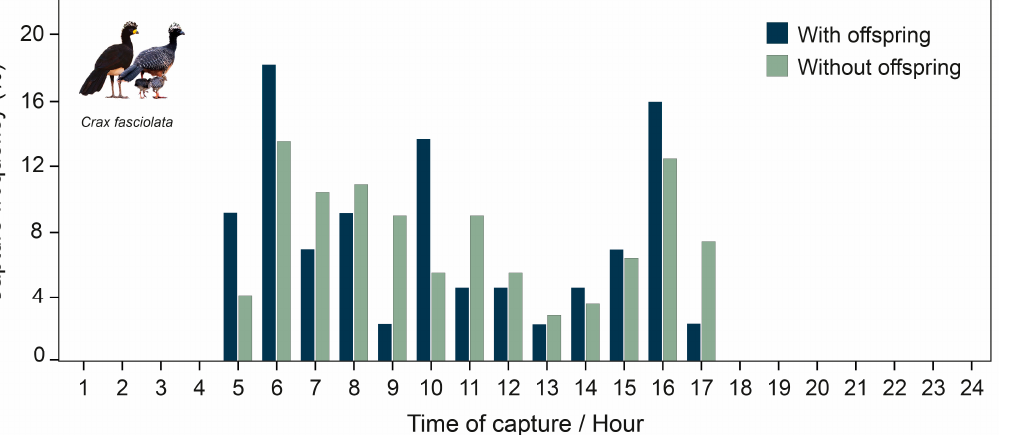
Figure 5. Frequency (%) of independent captures of Bare-faced Curassow ( Crax fasciolata ) (based on a 30 min independence interval) with and without offspring obtained in the Northern Pantanal (Mato Grosso, Brazil) from July 2015 to December 2017, grouped into 1 h periods.